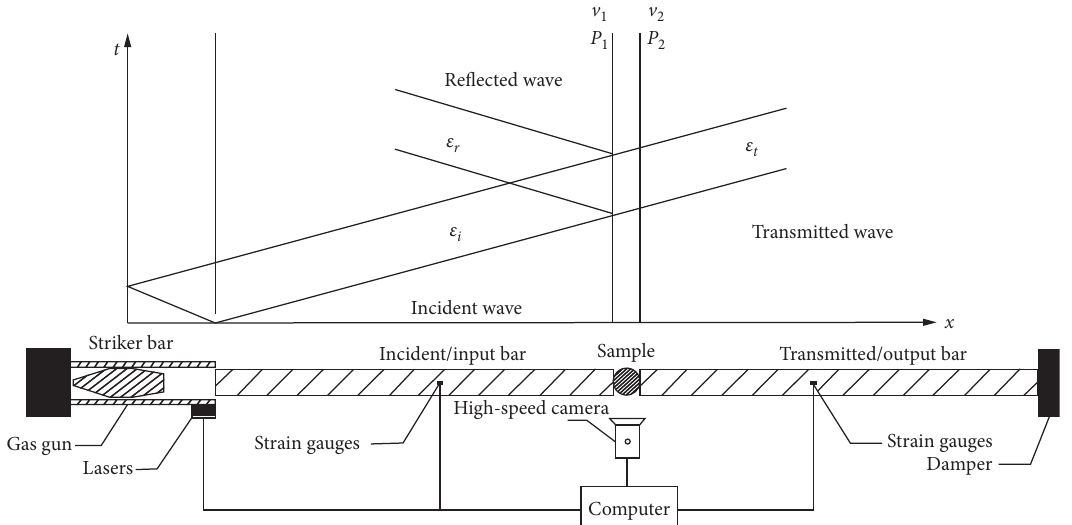
Figure 2: Schematics of a split-Hopkinson pressure bar (SHPB) system and the x-t diagram of stress wave propagation in the SHPB.